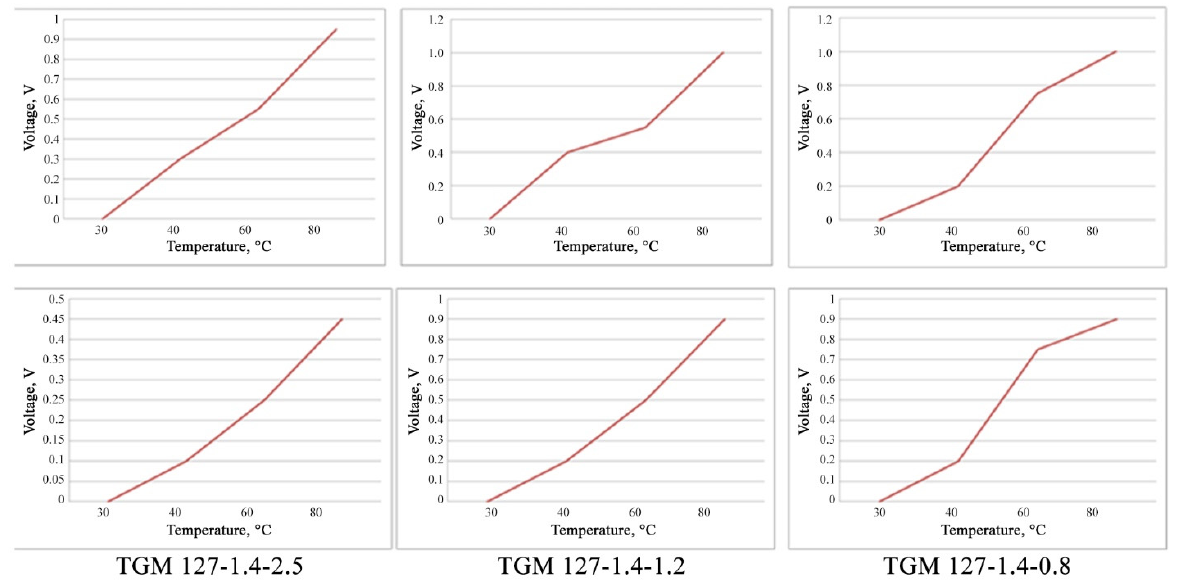
Figure 13. Dependences of the output indicators of the thermoelectric generators: TGM 127-1.4-2.5; TGM 199-1.4-0.8; TGM 127-1.4-1.2.